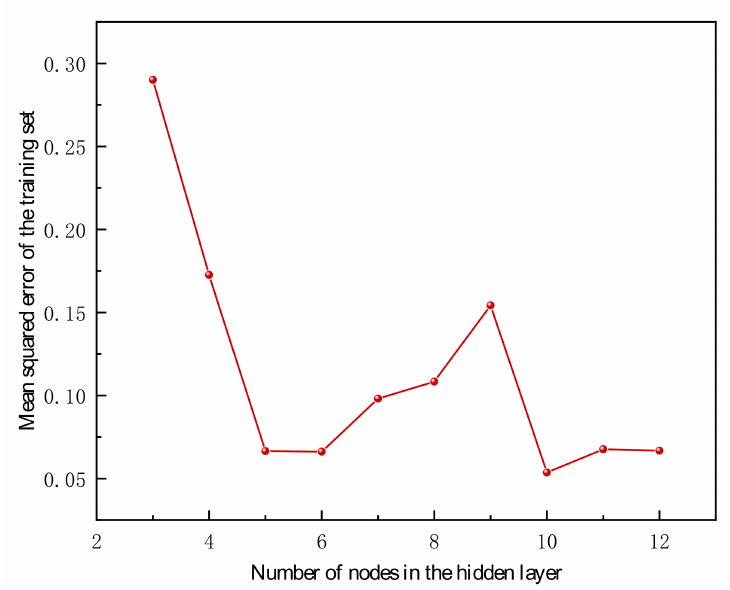
Figure 10. MSE of different number of hidden layer nodes for SSA-ENN